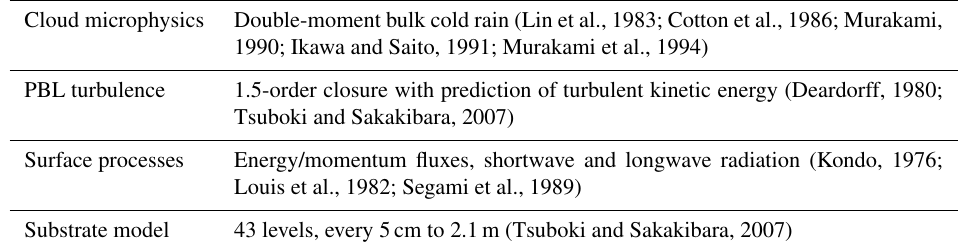
Figure 6. Distribution of 24h accumulated rainfall (mm, color) in Taiwan (a) from the rain-gauge observations from 16:00UTC on 1 June to 16:00UTC on 2 June 2017 (source: CWB) and from three model experiments of (b) F1, (c) F1-NNT, and (d) F1-NT, respectively, all for the same 24h period. The maximum values in the northern coast (triangles) and those near northern Taiwan in model experiments (dots) are labeled. Table 1. The physical package used by all CReSS experiments (with references) in this